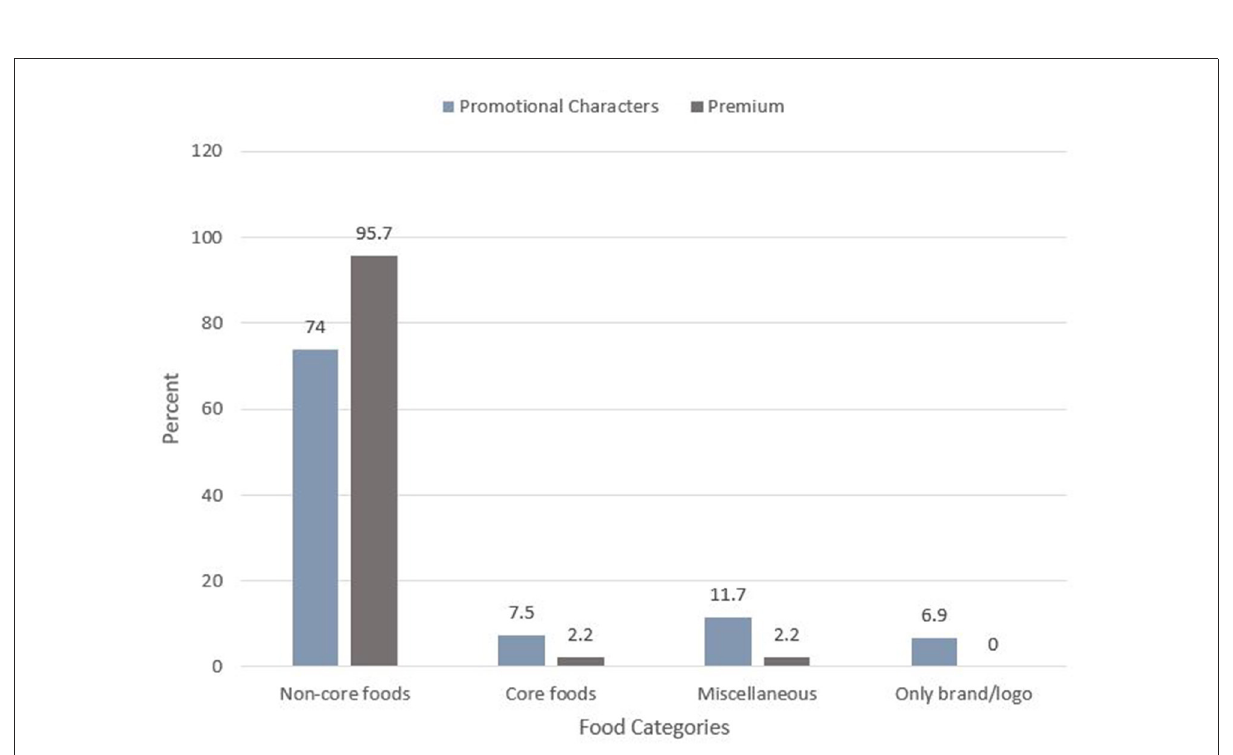
FIGURE4 Promotional technique used on food advertisements by food